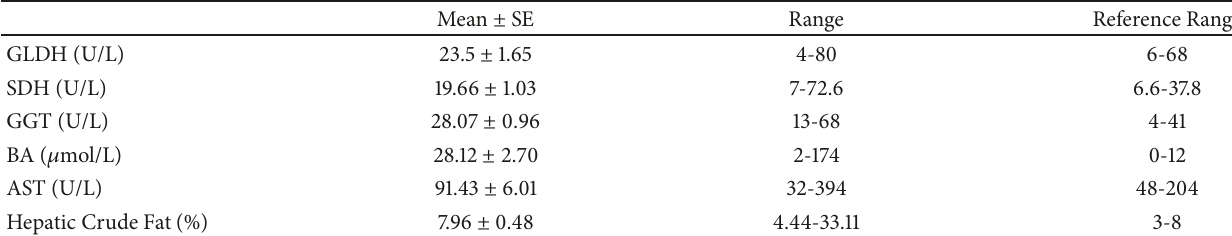
Table 1: Liver leakage enzymes, BA, and hepatic CF data.